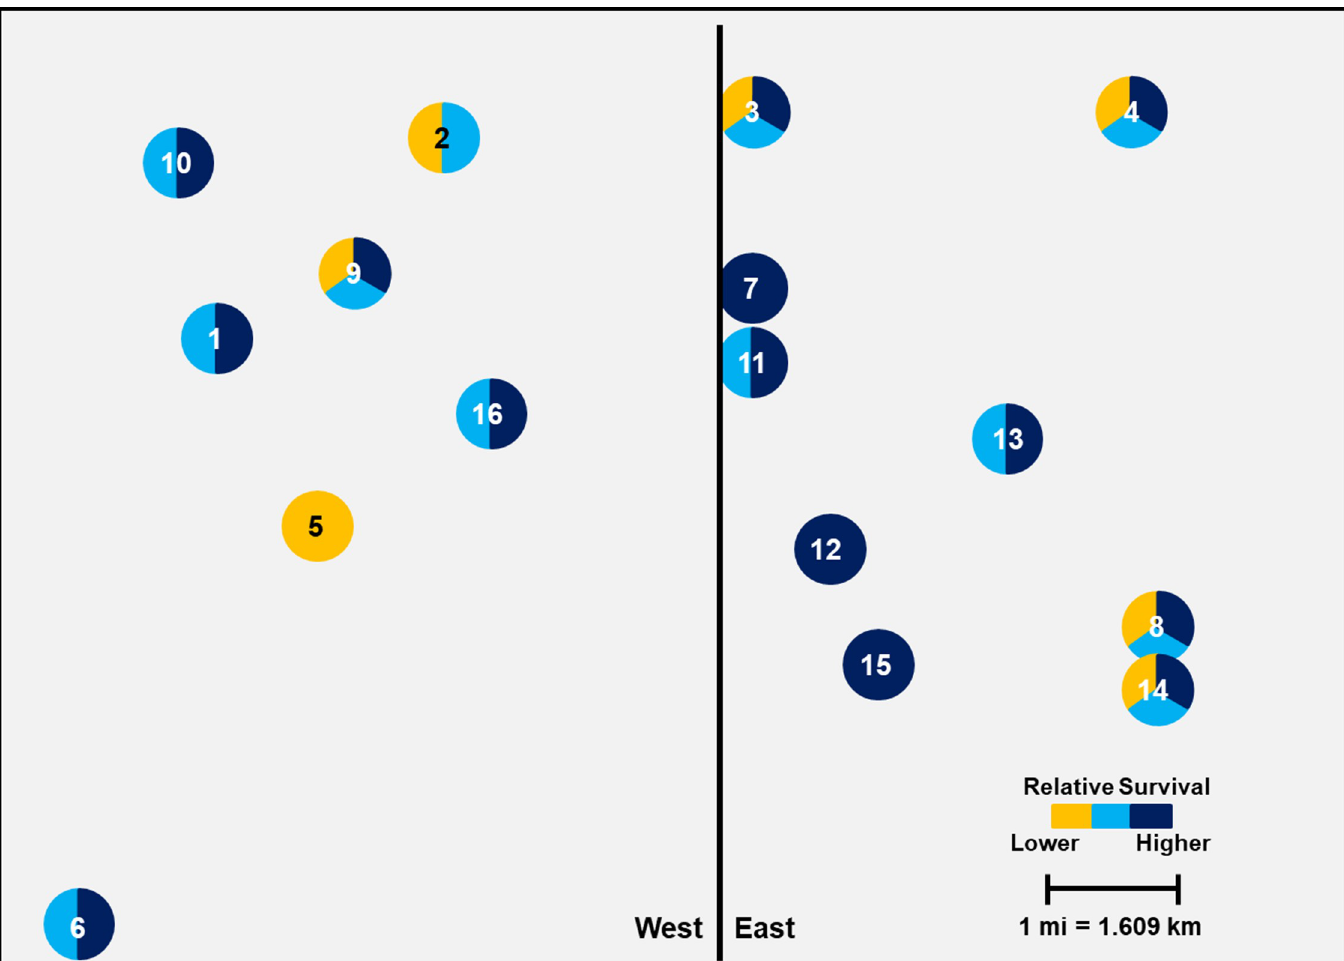
Fig 9. Spatial variation in mean mCry3A survival of WCR larvae among sampling sites in Buffalo County. Mean proportional survival ranged from 0.11 ± 0.03 to 0.46 ± 0.05. Circles containing the same color(s) are not significantly different (generalized linear model, P > 0.05; LSMEANS